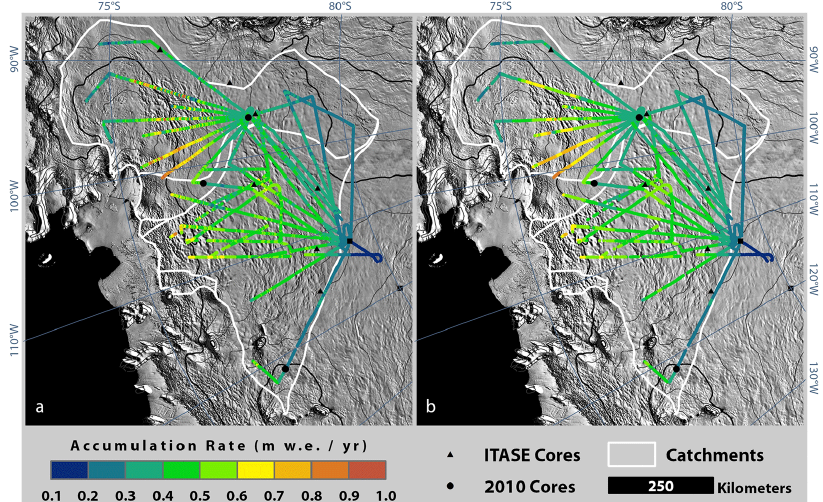
Figure 6. The (a) raw and (b) smoothed radar-derived accumulation rates. (a) The raw accumulation rates derived from the accumulation radar, including the bias-corrected rates as well as the 1985–2009 mean annual accumulation from the snow radar. (b) Same as from (a) except a 25km (tapered to 5km approaching the ends) running average has been